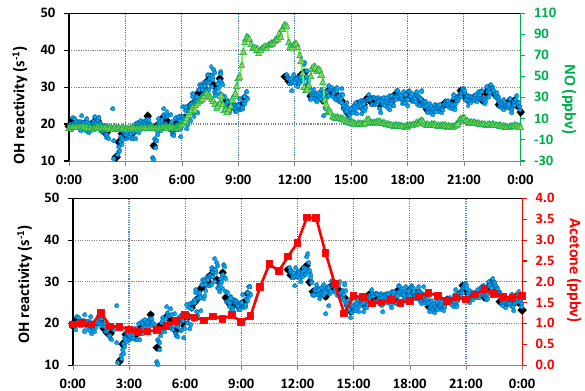
Fig. 10. Calculated (90 min time resolution red curve) versus the measured OH reactivity (2 min time resolution blue dots, 30 min average, black diamonds).